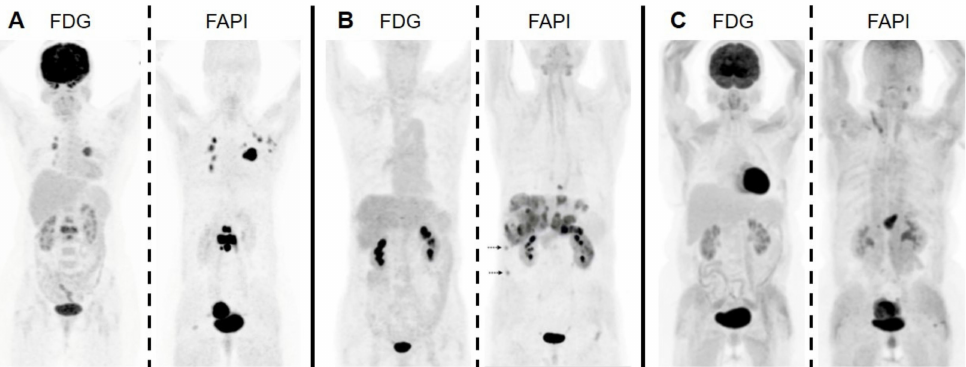
Figure 5. Cases in which FAP-targeted imaging outperformed [ 18 F]FDG PET/CT. ( A ) Invasive lymphnodal metastatic duct breast carcinoma. ( B ) Pancreatic duct adenocarcinoma with liver metastases. ( C ) Poorly differentiated gastric adenocarcinoma. Image sections were taken from Kömek et al., Chen et al. and Kuten et al.; copyright Springer-Verlag GmbH Germany, part of Springer Nature